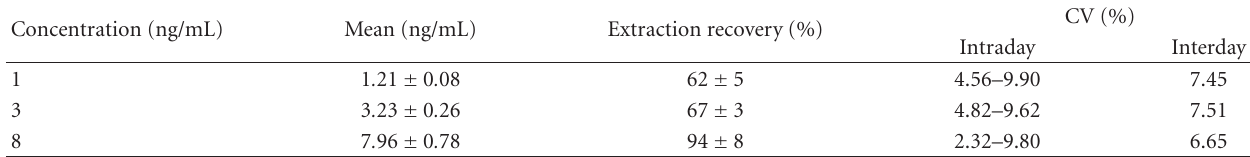
Table 3: Recovery and precision for metildigoxin in spiked whole blood